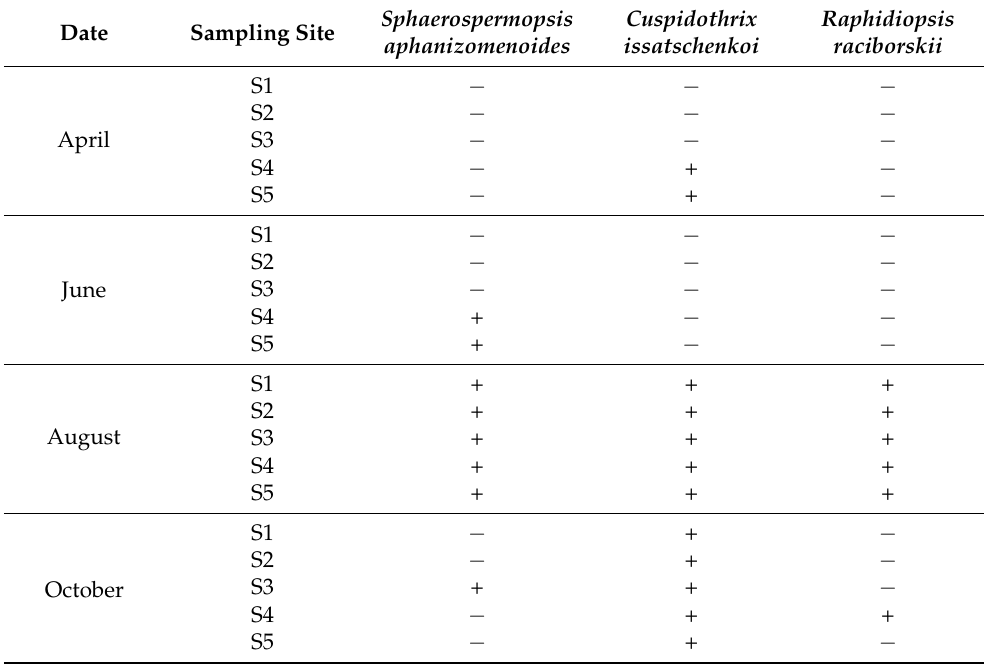
Table 3. Appearance of invasive cyanobacteria species ( ≥ 5% of the total biomass) in phytoplankton of Lake Sztynorckie during the whole growing season in 2020. Sphaerospermopsis Cuspidothrix Raphidiopsis Sampling Site aphanizomenoides issatschenkoi